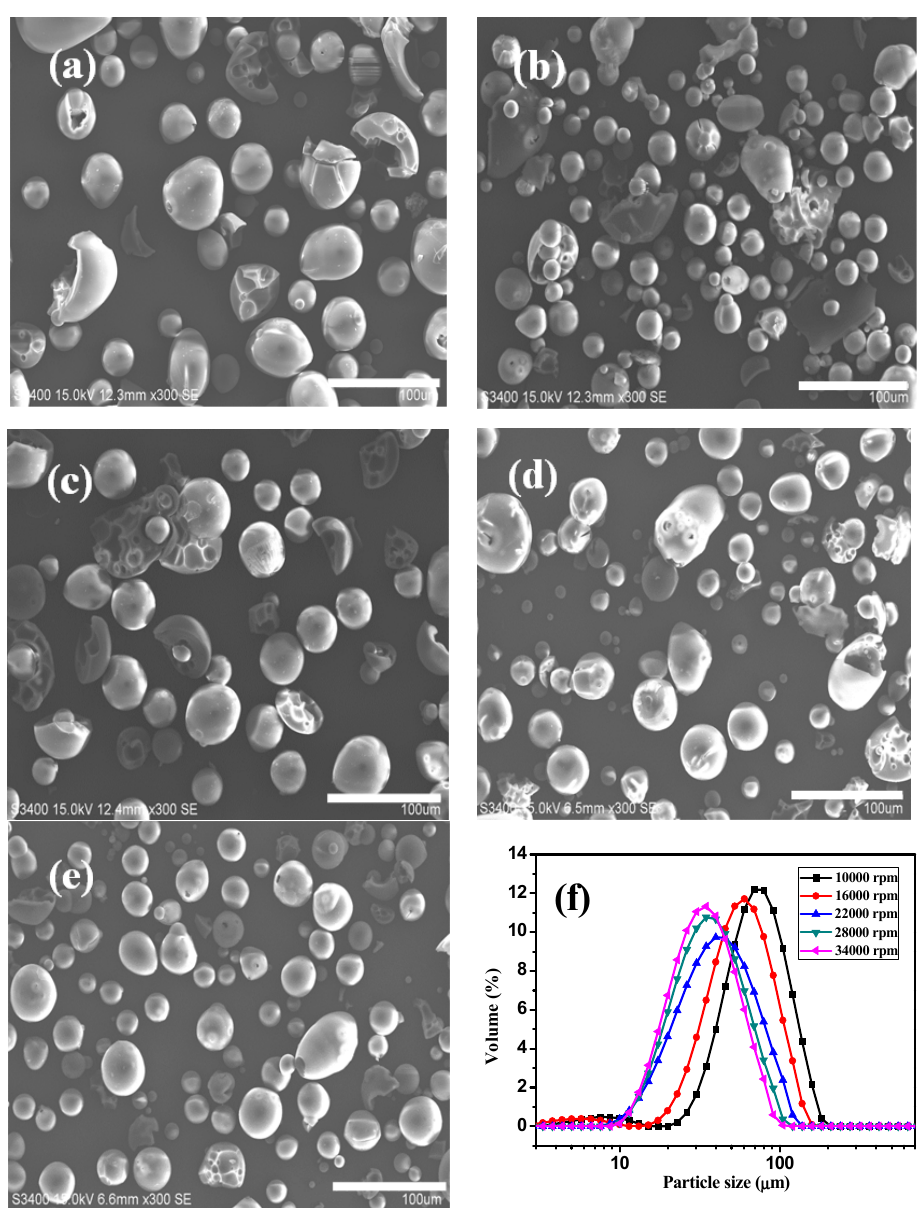
Figure 4. SEM images of the microspheres prepared at different atomizer rotational speeds: ( a ) 10,000 r/min; ( b ) 16,000 r/min; ( c ) 22,000 r/min; ( d ) 28,000 r/min, and ( e ) 34,000 r/min; ( f ) Effects of atomizer rotational speed on particle size and size distribution of the formed microspheres at 220 °C drying temperature.